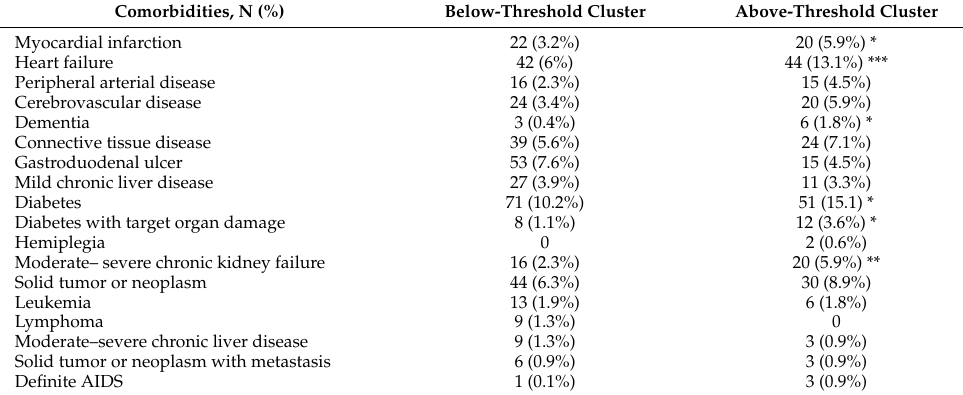
Table 4. Comorbidities in the two clusters of patients.